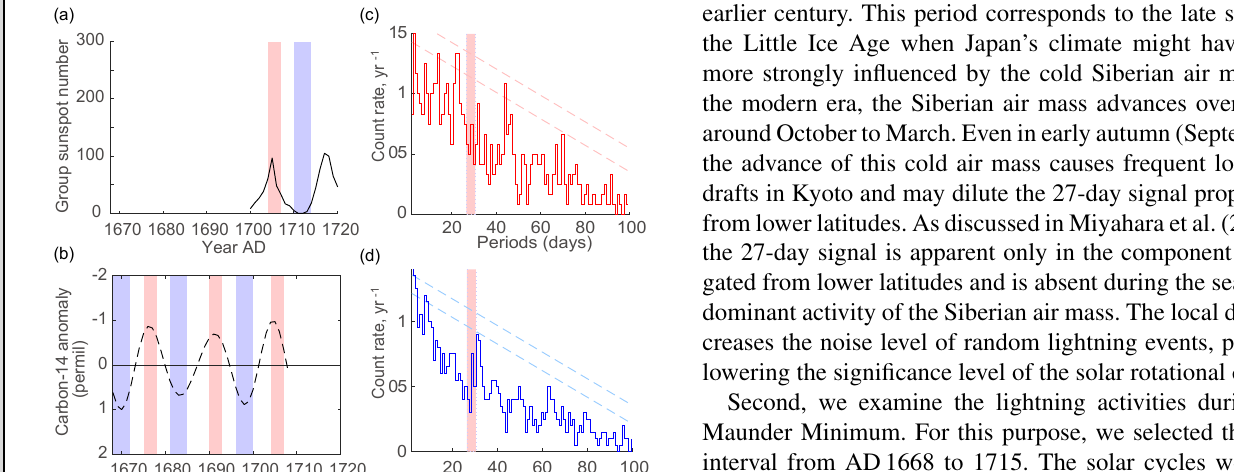
signal is delayed by slightly longer than 2 years. Neverthe- less, the solar cycle maxima reconstructed by using the above method successfully reproduce the solar cycle maxima at the end of the Maunder Minimum with no dating error (Fig.